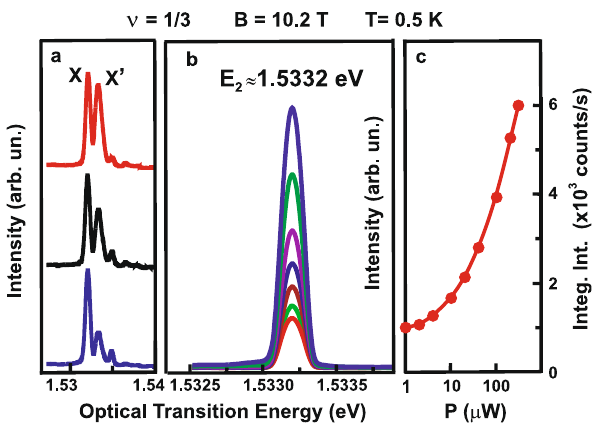
Fig. 5 Resonant re fl ection. a Spectra of photoinduced resonant re fl ection obtained by varying the wavelength of the probing (second) radiation source at a fi xed wavelength of the fi rst radiation source employed to create excitations in the electron system, given pumping radiation of the fi rst radiation source with 1.537 eV, at power levels of 20, 100, and 300 μ W (from bottom to top). X peak indicates the transition from 0LL of heavy holes to the higher spin sublevel of the 0LL of electrons, and X ′ is associated with the creation of excitation in the electron system. b Amplitude of photoinduced resonant re fl ection measured for the fi xed photon energies of 1.537 and 1.5332 eV of the fi rst and second radiation sources, respectively, at a constant power level of the second source E 2 and varied power level of the fi rst source. The linewidth of the photoinduced resonant re fl ection line is de fi ned by the slit of the spectrometer used to register the scattered radiation. c Dependence of the photoinduced resonance re fl ection intensity (taken from b ) on the power level of the fi rst radiation source.